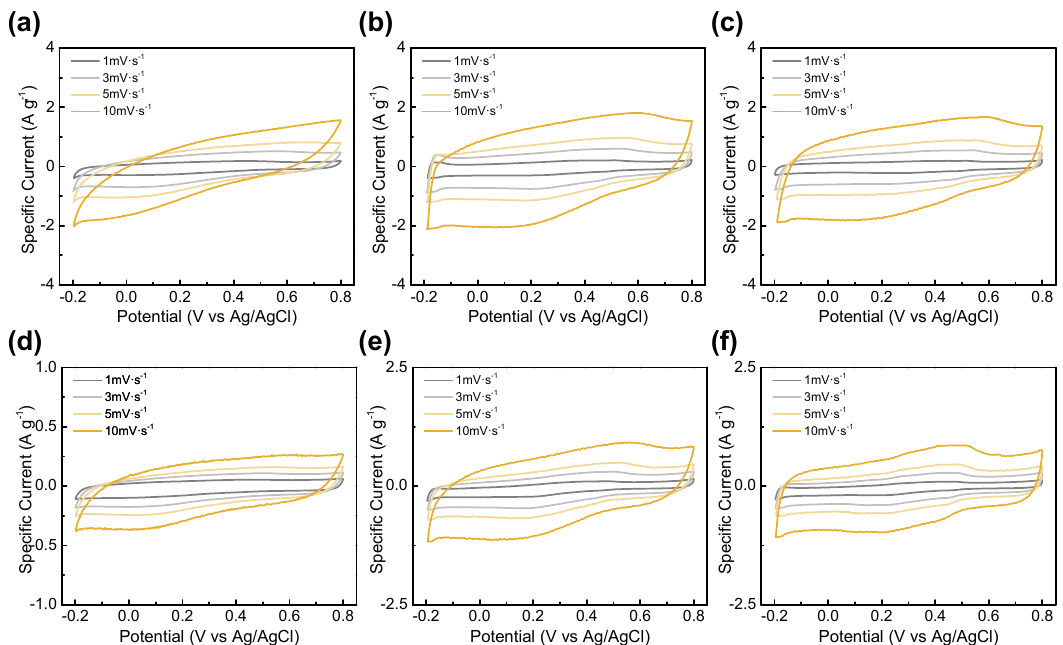
Figure 6. Cyclic voltammograms of ( a ) BTC-612, ( b ) BTC-613, ( c ) BTC-614, ( d ) BTC-712, ( e ) BTC-713, and ( f ) BTC-714 at scan rate from 1 to 10 mV∙s −1 .